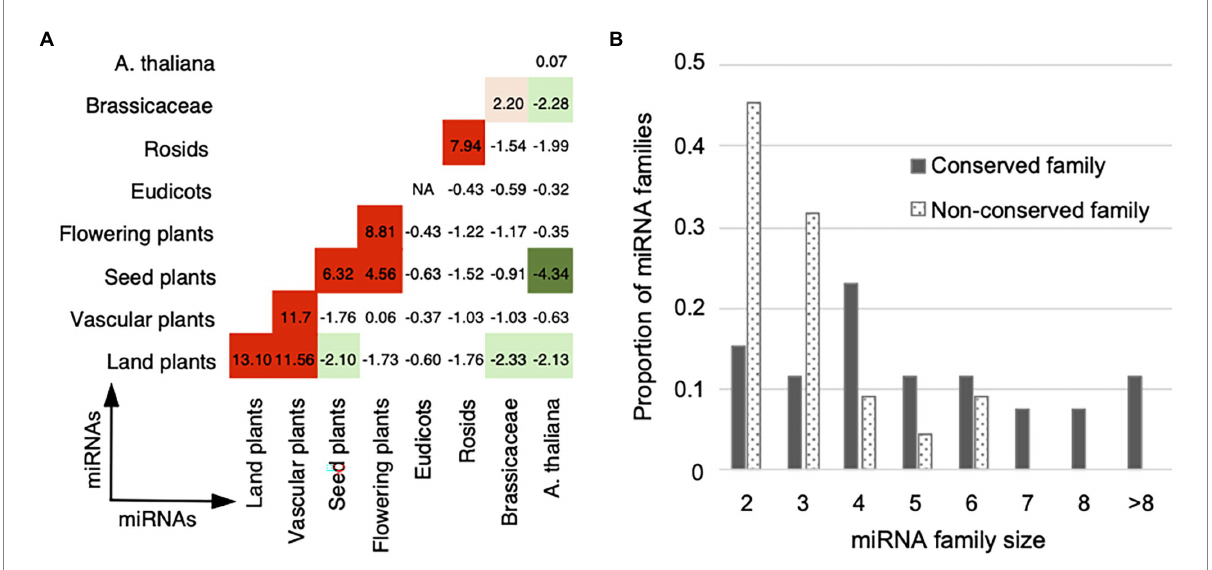
FIGURE 5 Cooperation age preference for miRNA pairs. (A) Cooperation age preference for miRNA pairs. The observed number of cooperative miRNA pairs within and between age groups in the real network was compared with the expected numbers in the 1,000 randomized networks with the same degree and age distributions (see Materials and methods). The enrichment was calculated using Z-score (labeled within and between age groups) and the corrected p -value for multiple hypothesis testing. Overrepresentative results are shown in red and underrepresentative results are in green (see the same legend in Figure 2). (B) Distribution of the family size for the conserved (gray bar) and non-conserved (dotted bar) miRNA families. The conserved miRNA families are of larger size than the non-conserved